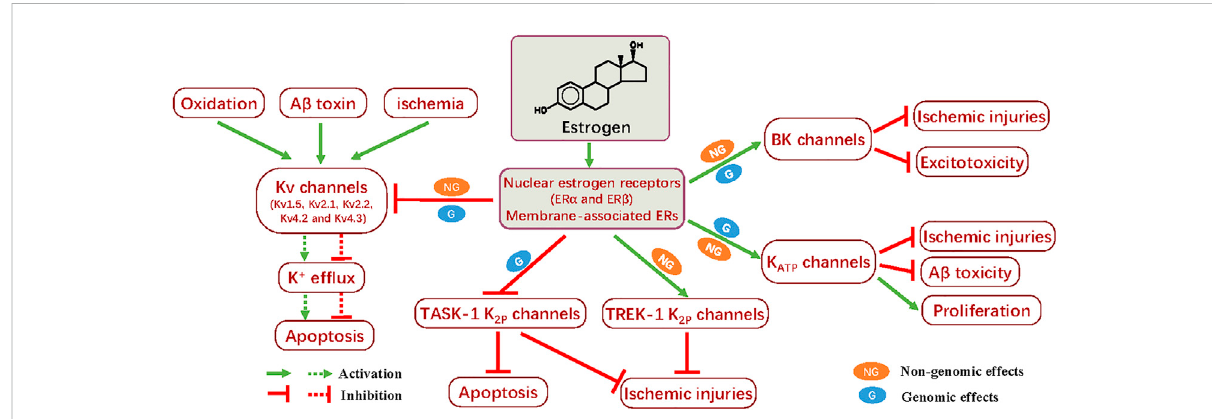
FIGURE 1 Summary of the neuroprotective effects of estrogens through modulation of potassium channels. Treatment with estrogen generates neuroprotectiveactionsbyopposingapoptosisandischemicinjuries;thiseffectismediatedbytheinhibitoryimpactontheKv,includingKv1.5,Kv2.1, Kv2.2, Kv4.2, and Kv4.3, and TASK-1 K 2P channels. On the other hand, enhanced activity of BK, K ATP , and TREK-1 K 2P channels induced by estrogen also facilitates the mitigation of ischemic injuries, as well as A β toxicity or excitotocity, even promoting cell proliferation. The nuclear estrogen receptors (ER α and ER β ) and membrane-associated ERs participate in the genomic and non-genomic effects, respectively. These distinct approaches could, at least in part, underlie the neuroprotective mechanism of estrogen in modulating K +